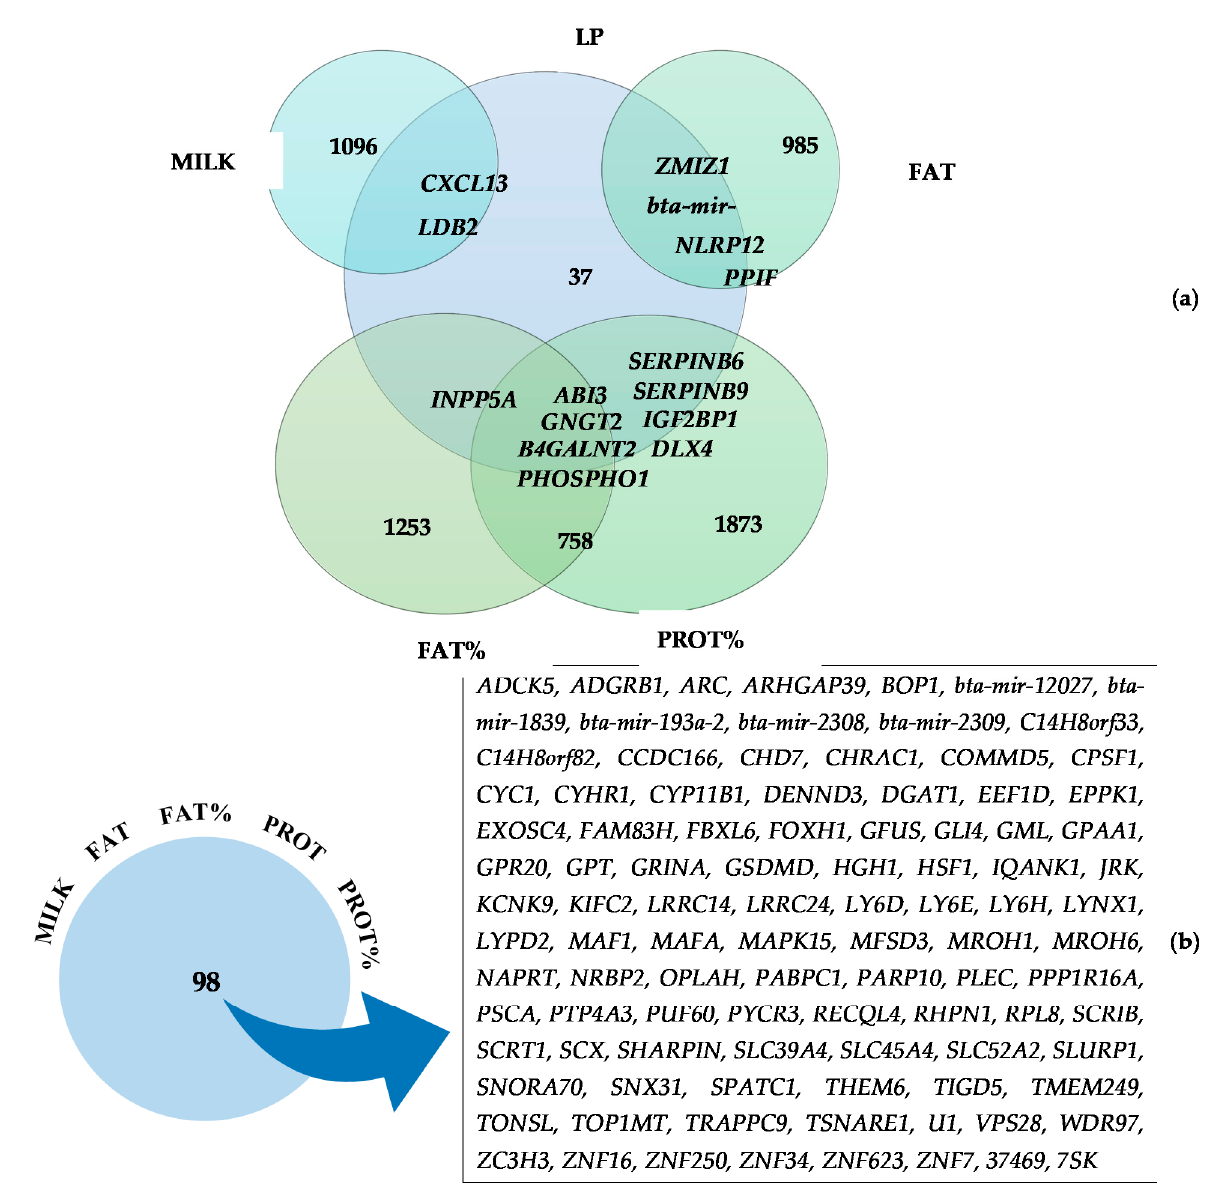
Figure 2. Number of genes and list of common genes related to lactation persistency ( a ) and associated between production traits ( b ), considering milk yield (MILK), fat yield (FAT), fat percentage (FAT%), protein yield (PROT), protein percentage (PROT%) and lactation persistency (LP).